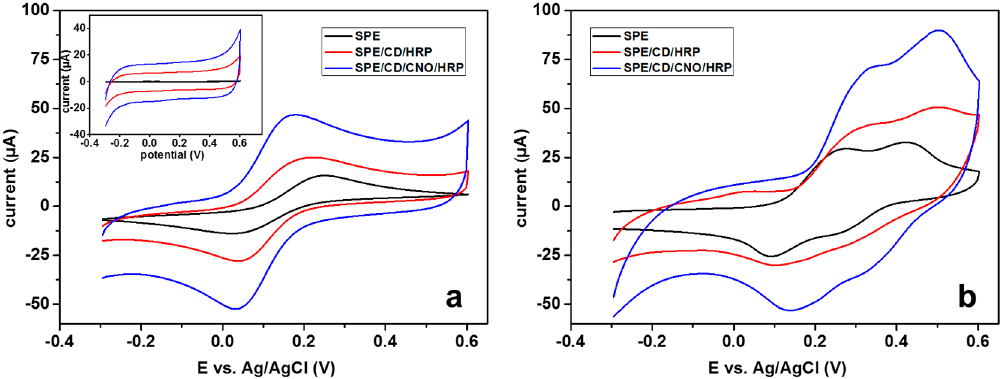
Figure 4. ( a ) HRTEM image of the starting CNOs. ( b ) TEM image of the CD/CNO/HRP composite before deposition on the SPEs. ( c ) ESEM image of the bare SPE and ( d ) SPE/CD/CNO/HRP.